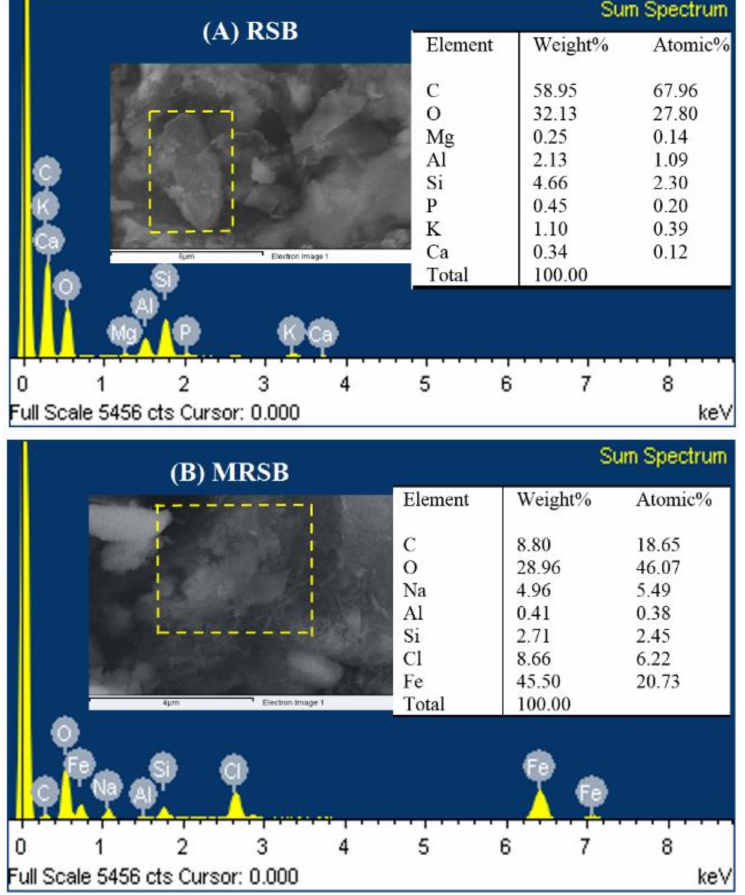
Figure 2. SEM images and EDX mapping of RSB ( A ) and MRSB ( B )